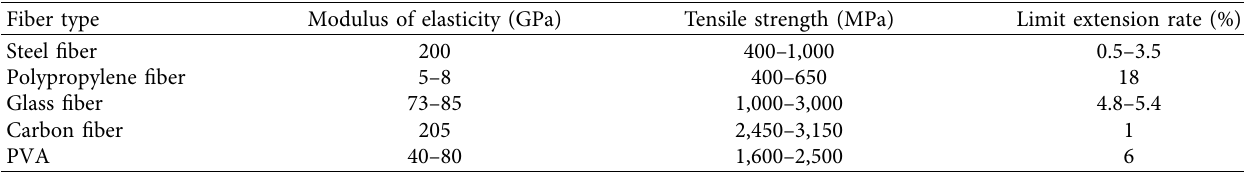
Table 1: Comparison of commonly used fiber